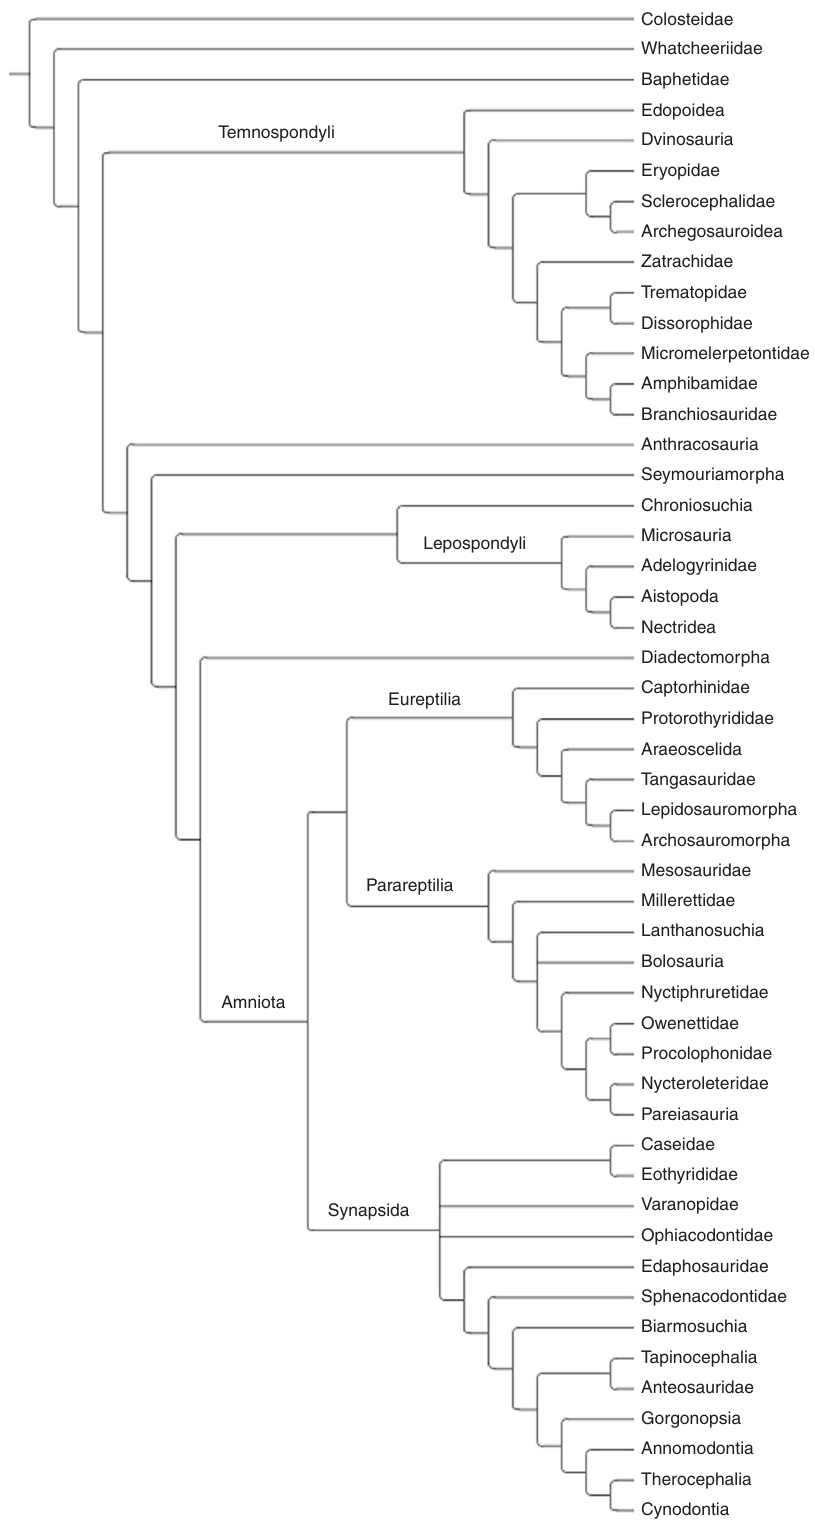
Fig. 5 Summary version of the supertree used in the